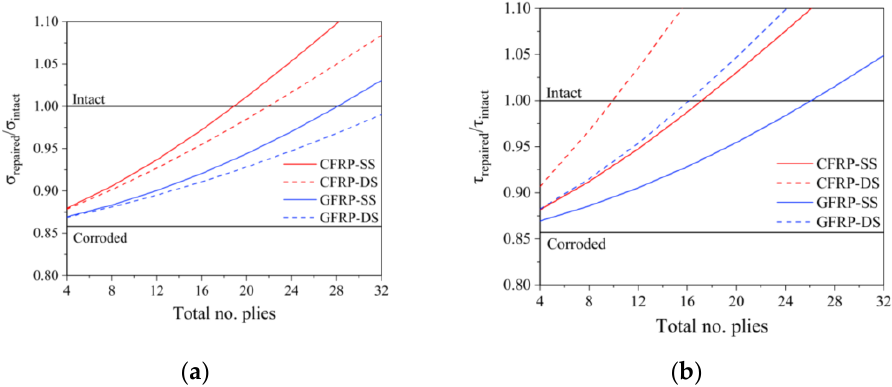
Figure 14. OFAT analysis for determining the repair’s optimal combination of material and config- uration (SS: single strap, DS: double strap) for the ( a ) compression and ( b ) shear buckling model.